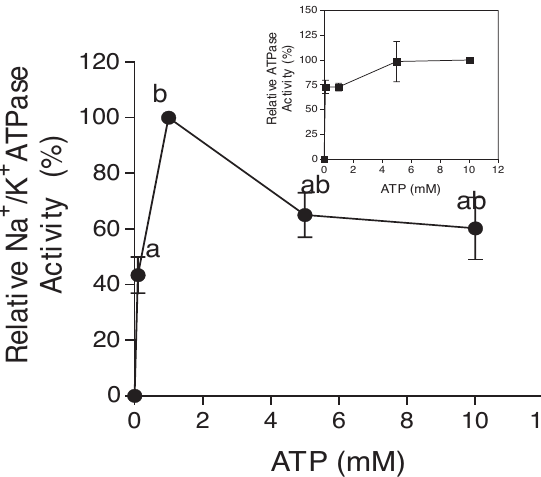
f ig . 1. – effect of atP (0.1-10.0 mM) on na + -K + atPase activity in chela muscle of C. angulatus . inset: residual (Mg 2+ -na + ) atPase activity. the values of na + -K + atPase and residual (Mg 2+ -na + ) atPase activity are expressed as a relation to the maximal activity (100%, na + -K + atPase activity: 61.8 ± 7.7 and (Mg 2+ -na + ) atPase activity: 63.6 ± 5.1 nmoles Pi x min -1 x mg prot -1 ). in some cases, de- viation bars were smaller than the symbols used. data are the mean ± S.E. for three to five crabs . Different letters indicate significant differences